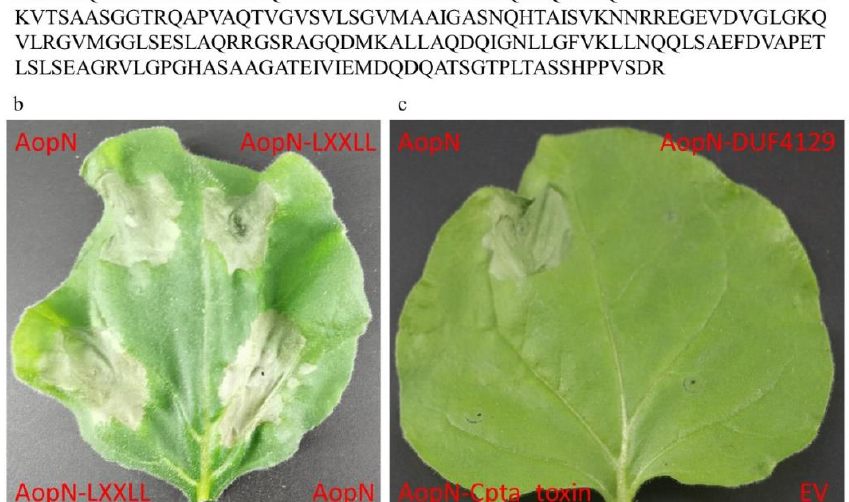
Figure 7. Analysis of the key motifs of AopN-induced programmed cell death (PCD). (a) Red font is the LXXLL motif prediction in AopN. ( b ) PCD symptoms induced by AopN-LXXLL. ( c ) Lack of PCD symptoms induced by AopN lacking DUF4129 and Cpta_toxin motifs. The experiments were performed three times, with similar results obtained each time. A. tumefaciens GV3101 carrying EV as control. Three independent assays were conducted and at least five plants with 10 different leaves were observed.